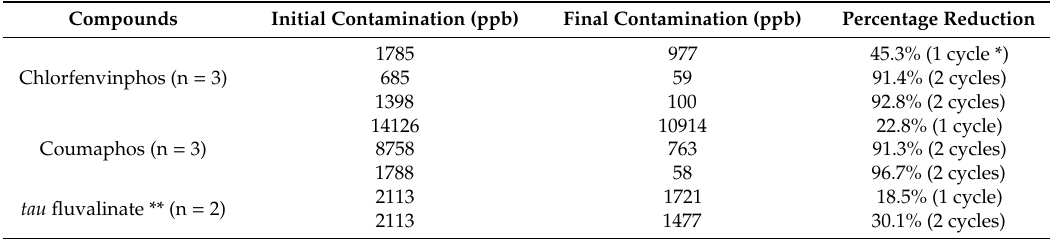
Table 1. Pesticide content (ppb) and percentage reduction (%) in beeswax before and after subjecting the samples to the industrial method of